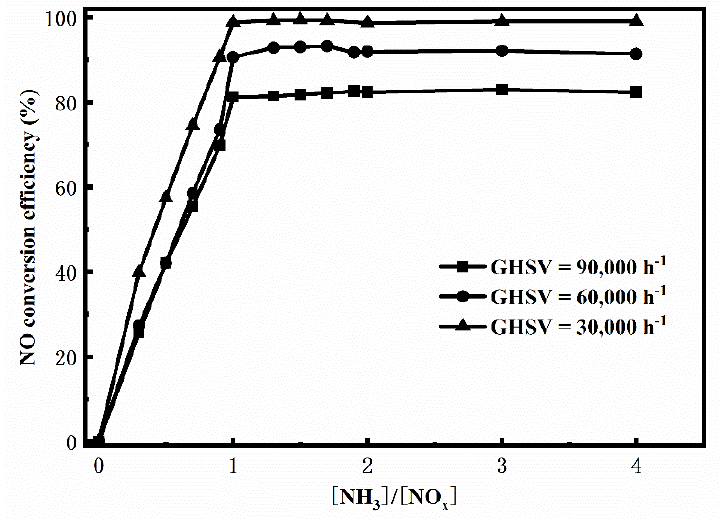
Figure 5. Effects of n [NH3] /n [NO] on NO conversion efficiency of Mn10Ce41/NG catalyst.